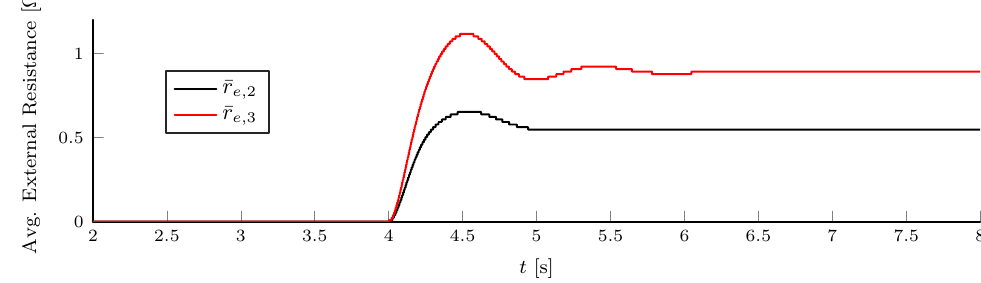
Figure 18. External resistances (phase a ); voltage-source control.